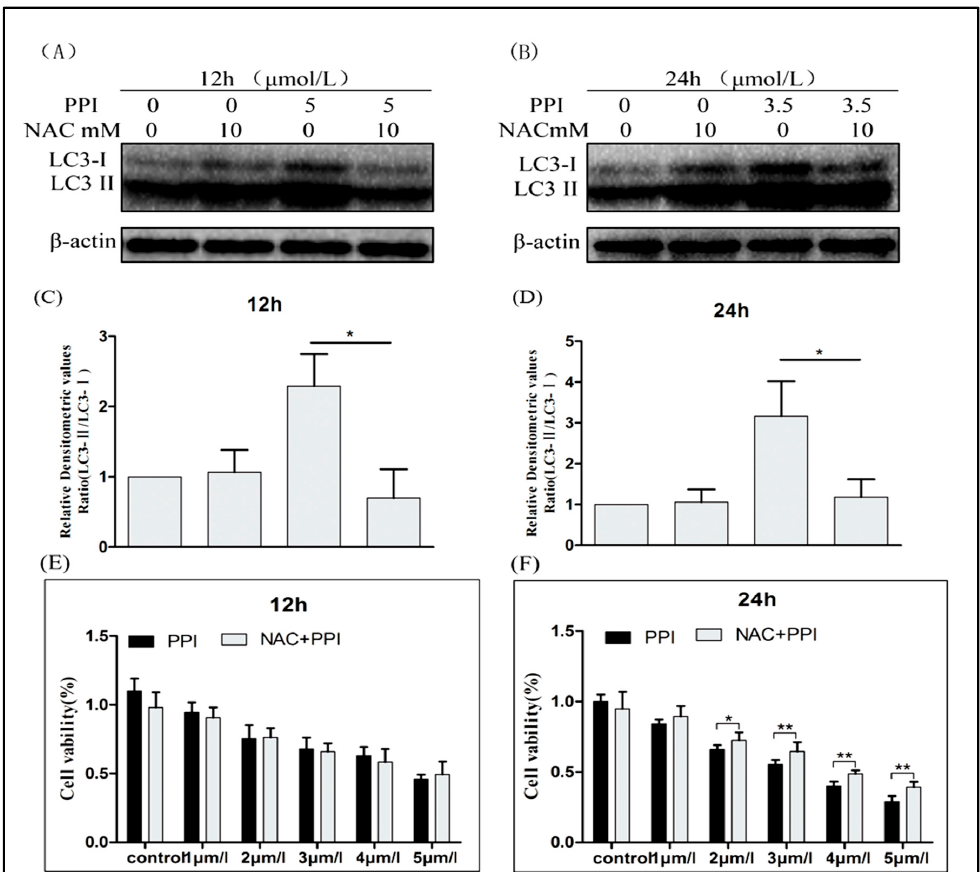
Figure 8. Effects of ROS on the autophagy and cell activity of SW480 cells induced by PPI. ( A , B ) LC3 protein level was examined by Western blot assay after treatment with PPI and NAC for 12 and 24 h, respectively; ( C , D ) the quantification of the ratio of LC3-II to LC3-I. ( E , F ) Cell viability was evaluated by MTT assay after treatment with PPI and NAC for 12 and 24 h, respectively. n = 3, the data are presented as means ± SEM. * p < 0.05; ** p < 0.01.